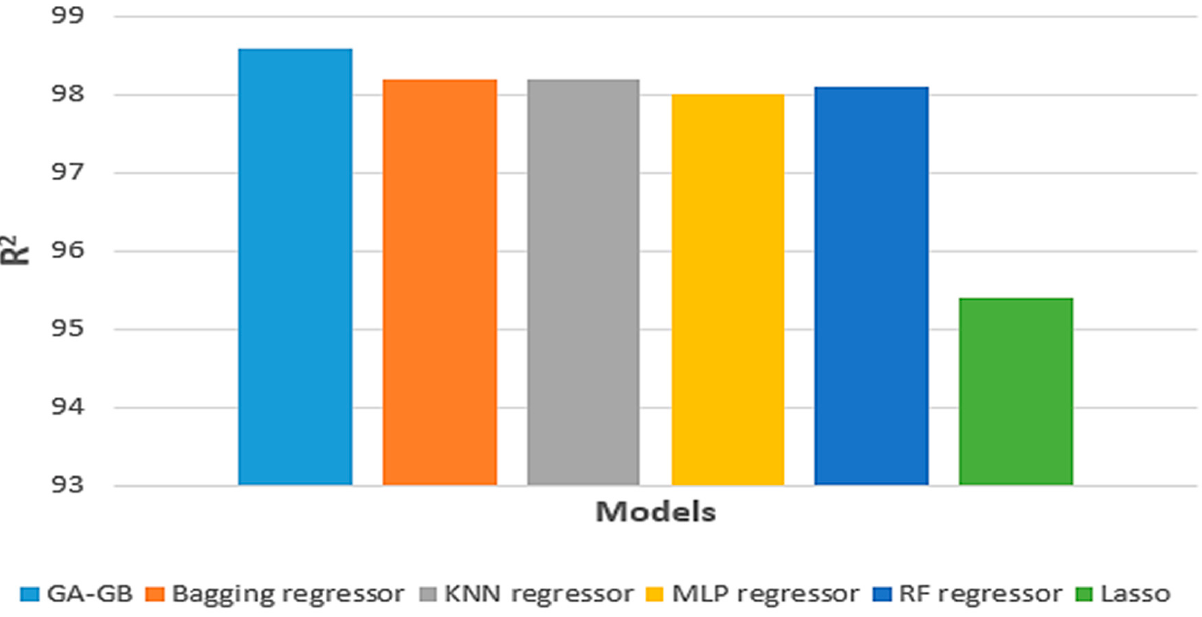
Figure 4. Comparison between the models used in the term of coefficient of determination ( R 2 ) using OD dataset.